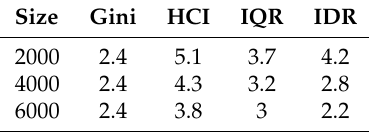
Table 8. Relative RMSE (%) of each parameter applying PSA with the stratified reference sample.